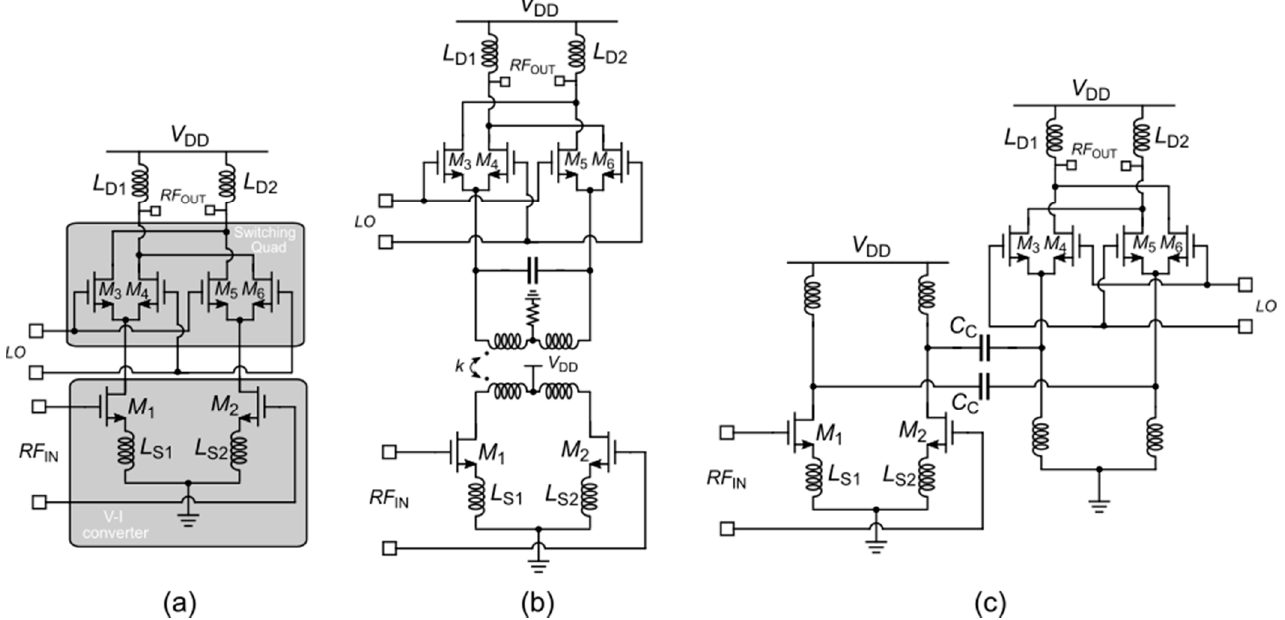
Figure 6. Double-balanced mixer topologies: ( a ) traditional Gilbert cell mixer; ( b ) TC Gilbert cell mixer; ( c ) CC Gilbert cell mixer.